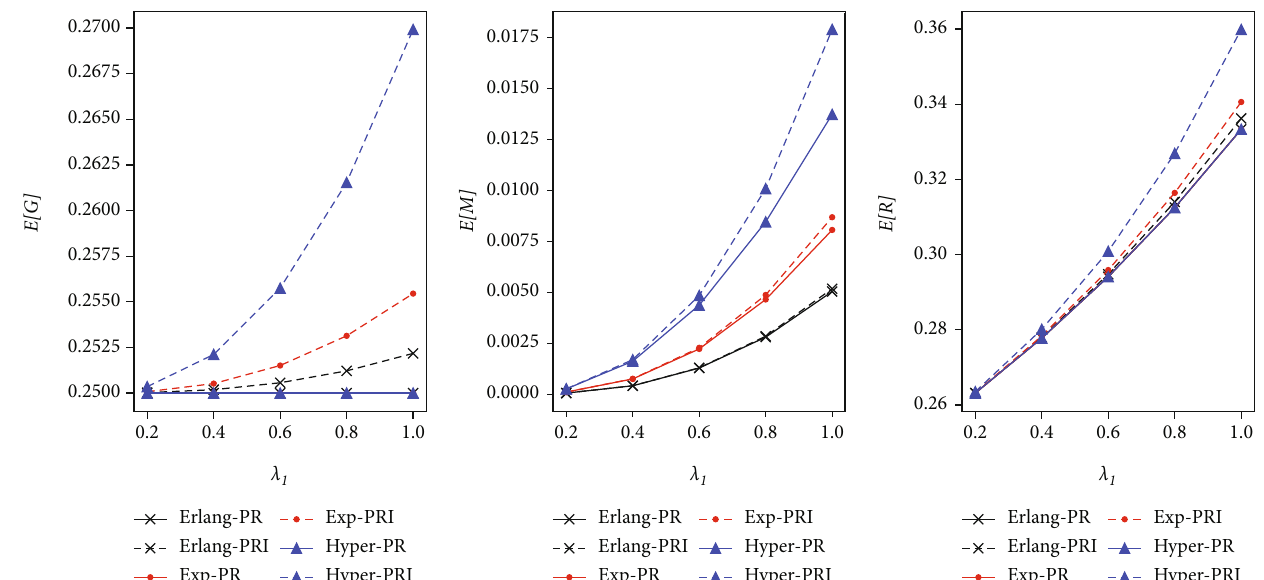
Figure 5: The expected gross service time, preemption occurrence, and occupation time of a class-2 customer for various values of λ